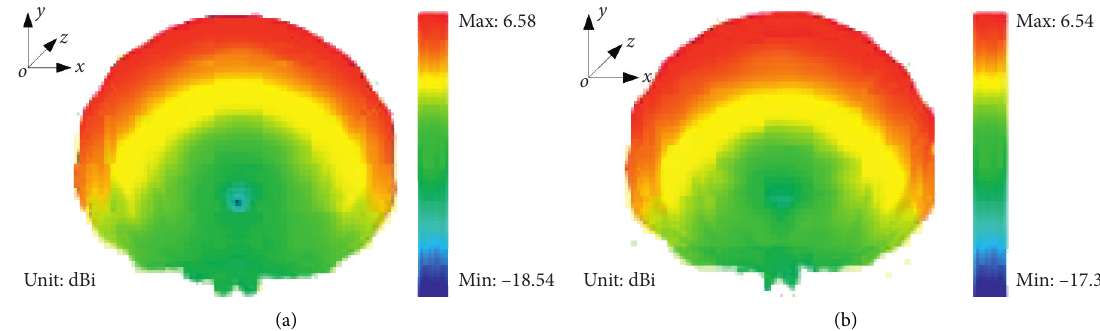
Figure 8: 3D radiation patterns of the compact quasi-Yagi antennas. (a) Rectangle shape. (b) Trapezoid shape.